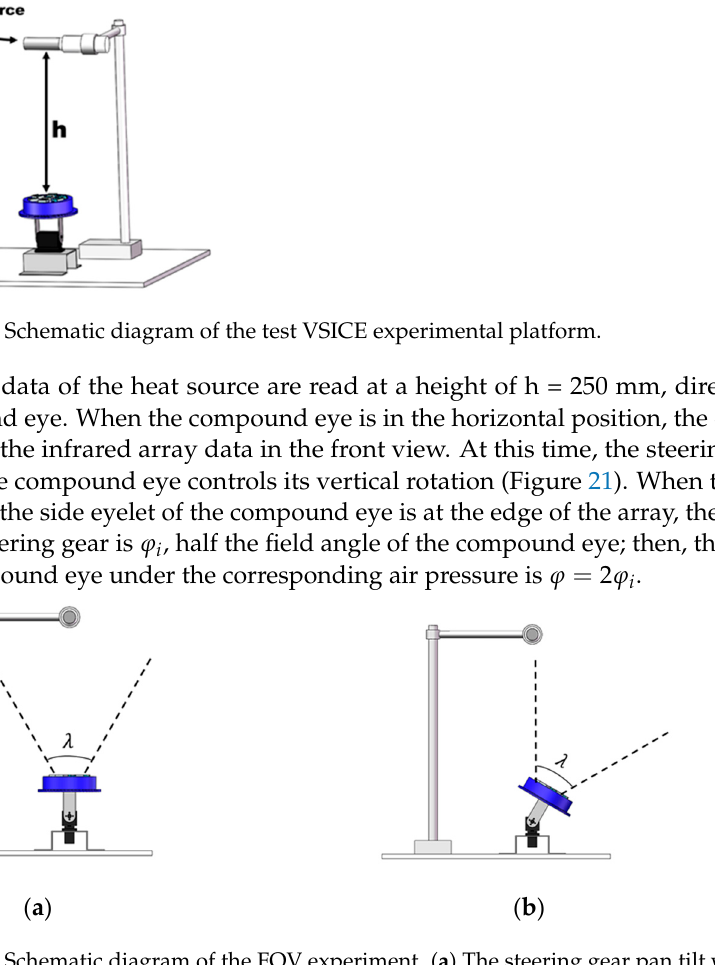
( c ) Figure 19. Horizontal distance–vertical displacement and air pressure–horizontal distance diagrams of the outer ring points (attachment point of SAM’s outer ring sensor and the corresponding point of CTPM’s outer ring sensor attachment point). ( a ) and ( b ) represent the outer ring point displace-